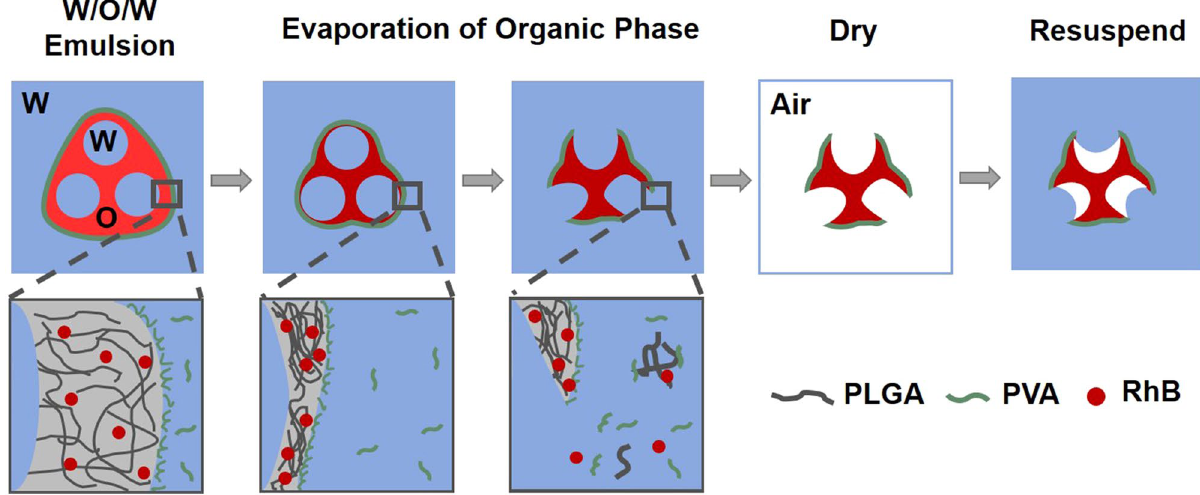
Figure 1. Formation of RhB-mcPLGA MPs using a modified water-organic-water (W/O/W) double emulsion method. Here, multiple internal sub-micron aqueous droplets are formed within a single organic droplet comprised of dichloromethane (DCM), PLGA, and RhB. The surrounding water phase is comprised of polyvinyl alcohol (PVA), which self assembles onto the O/W interface and stabilizes the multi-core droplet. During the evaporation of the DCM, thin edges of PLGA are formed at the apexes of the multi-core droplet. These thin edges eventually are ruptured, releasing the aqueous cores into the surrounding medium and forming the multi-cavity